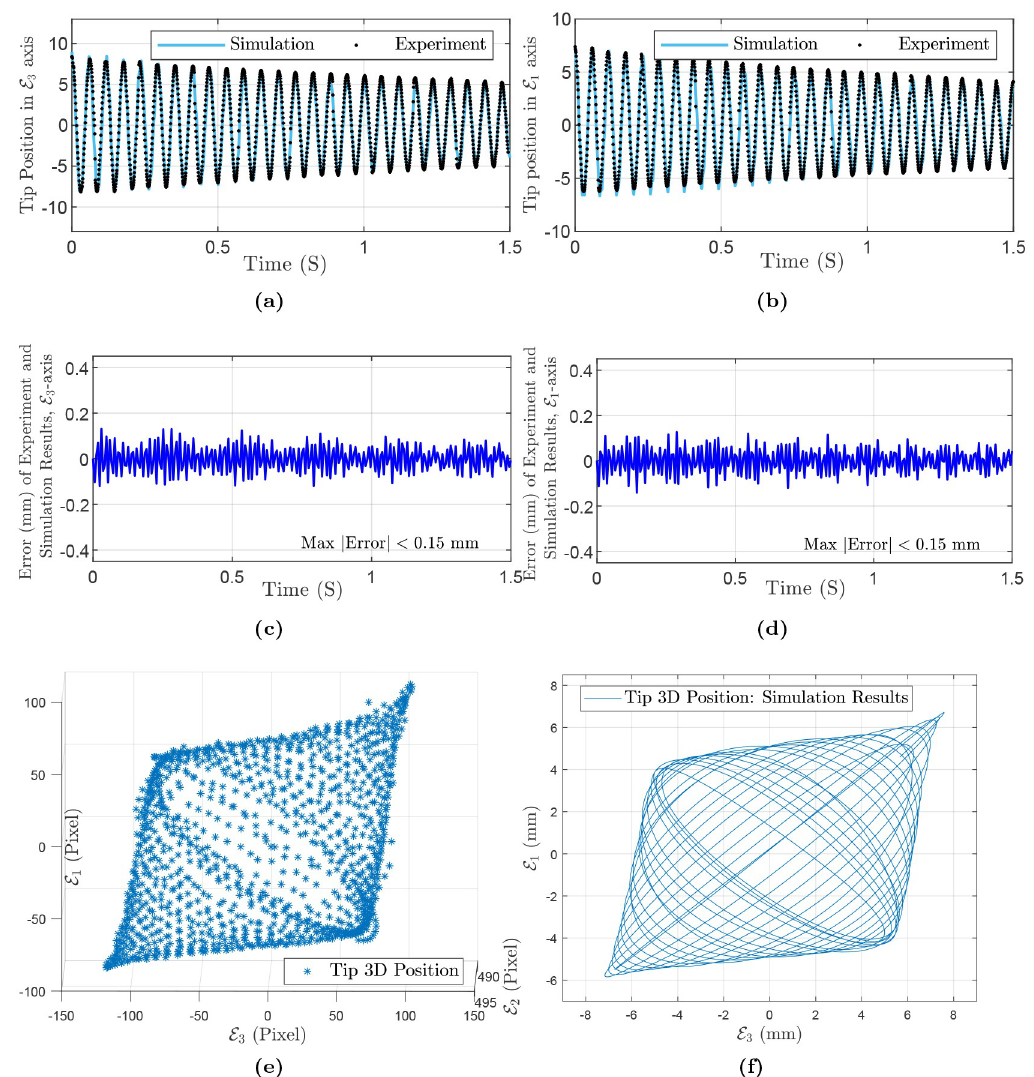
Fig 7. Simulation and experiment results for flexible rod (AlSi05), out-of-plane experiment: (a) Tip position in E direction. (b) Tip position in E